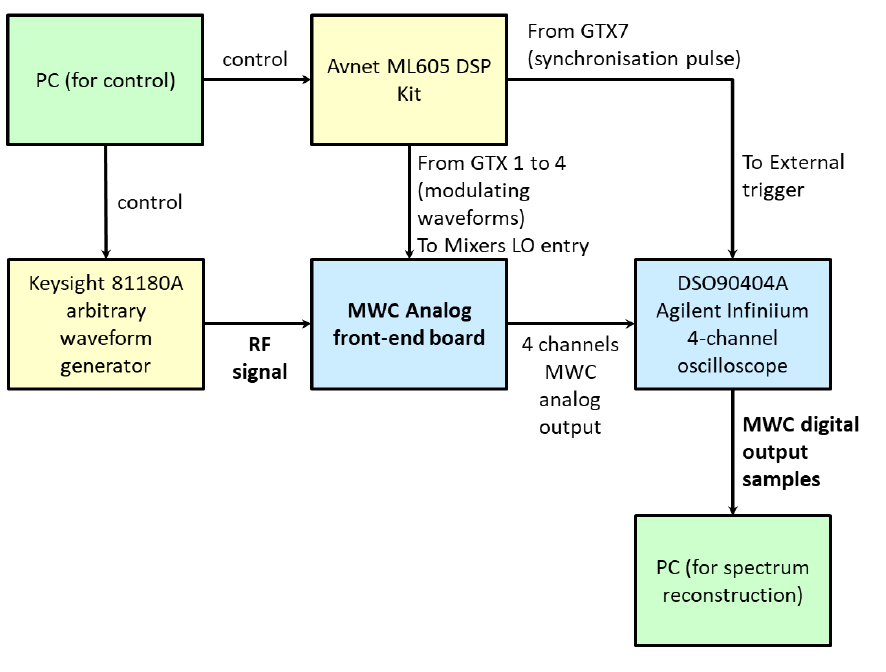
Figure 6. Experimental testbed for the evaluation of data reduction invariant LASSO algorithm.